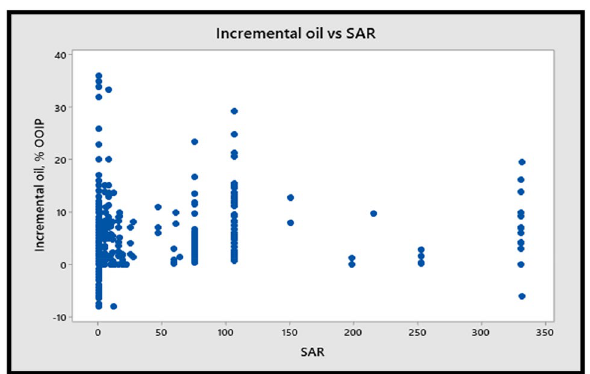
Fig. 4 Relation between sodium adsorption ratio (SAR) and addi- tional oil recovery